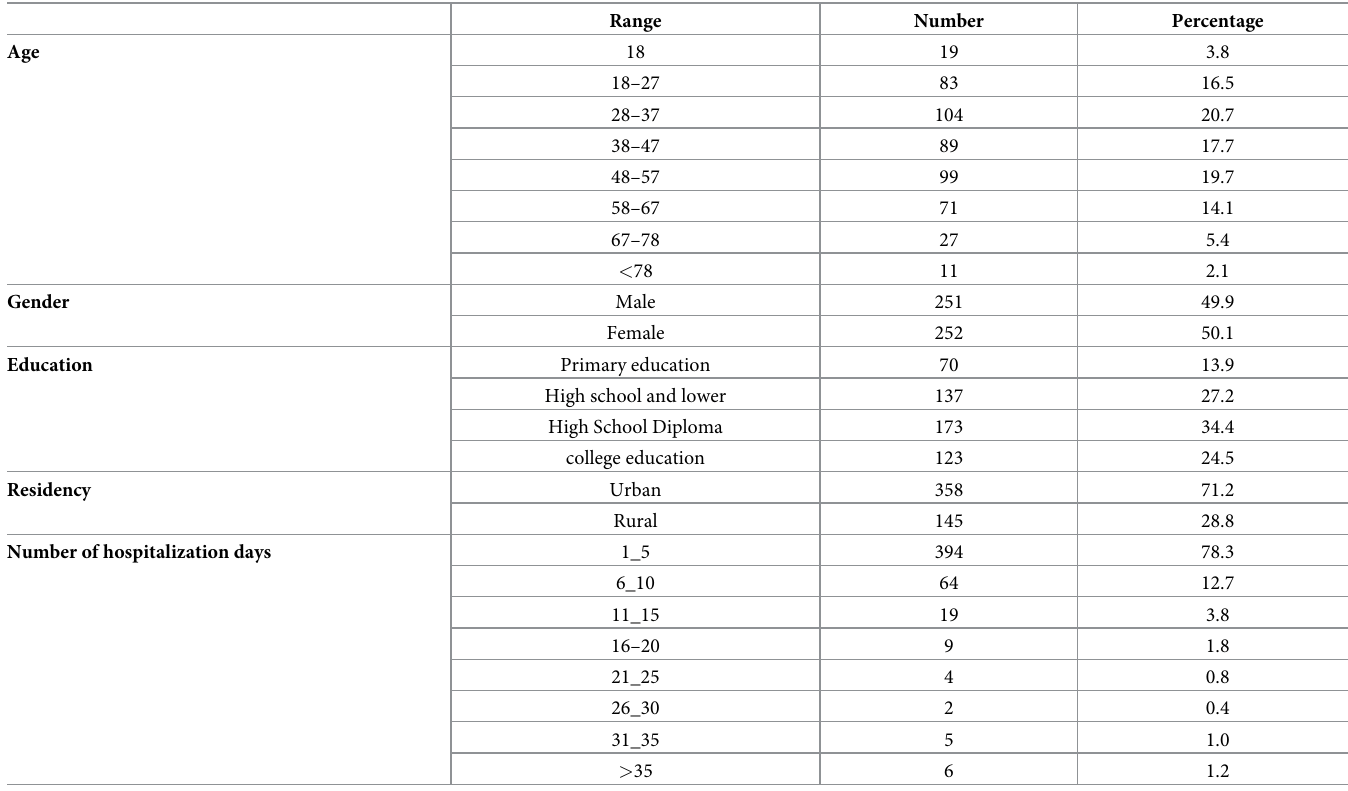
Table 2. Demographic characteristics of the participants.